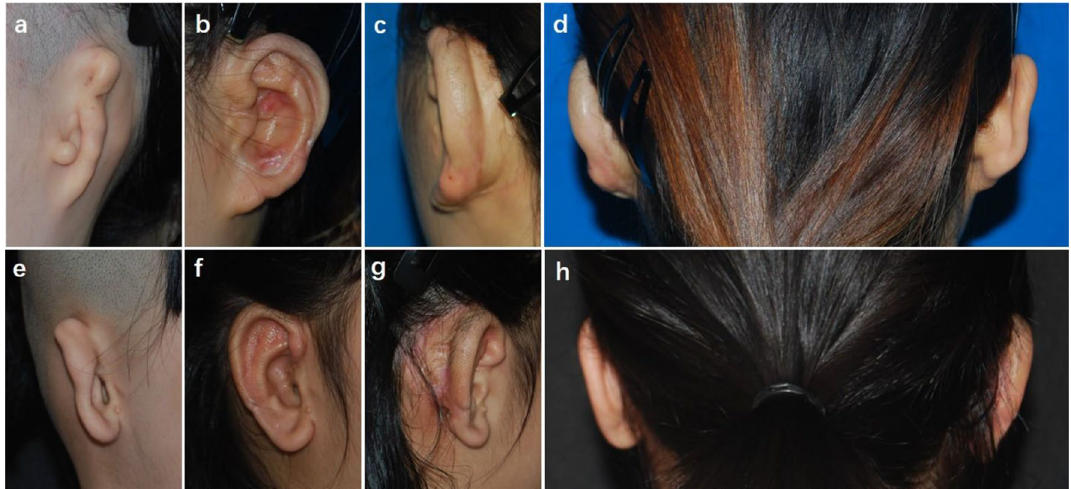
Figure 2. ( a ) A 26-year-old woman presented with congenital microtia, and she received ear elevation with autogenous cartilage as support material covered by RFF and a skin graft from the groin. ( b ) Postoperative oblique view at 30 months after ear elevation. ( c ) Postoperative oblique rear view showing that no obvious hypertrophic scar was observed. ( d ) Dorsal view showing that the cephaloauricular angle was nearly symmetric to the contralateral normal ear. ( e ) A 9-year-old girl presented with congenital microtia, and she received ear elevation with EH as support material covered by RFF and skin graft from scalp. ( f ) Postoperative oblique view at 12 months after the second stage of reconstruction. ( g ) Postoperative oblique rear view showing that no obvious hypertrophic scar occurred. ( h ) Dorsal view showing that the cephaloauricular sulcus approximated the normal